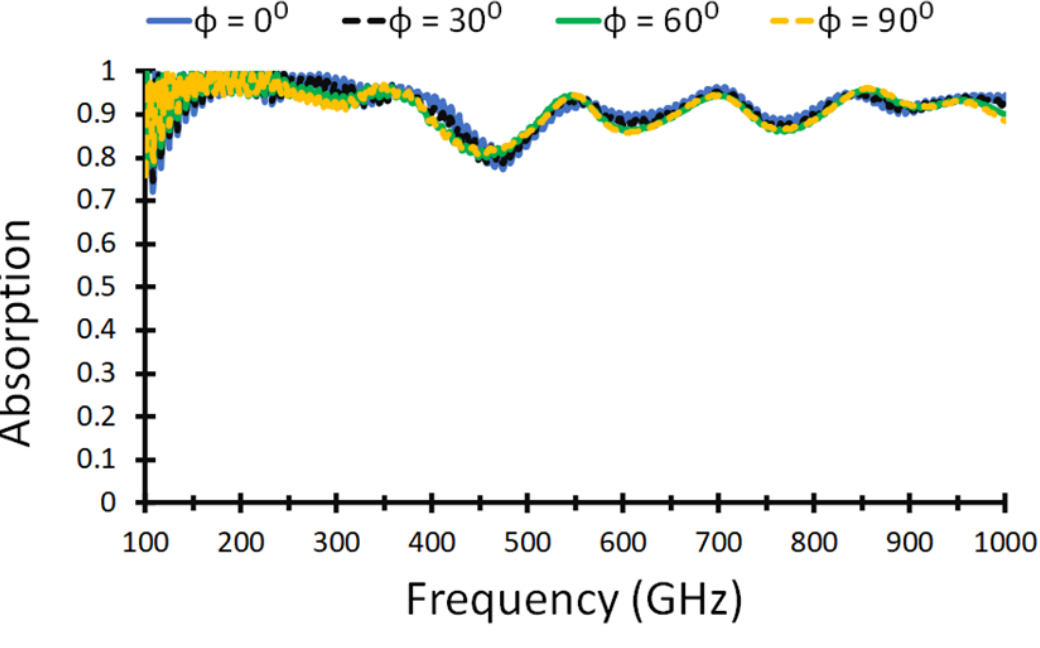
Figure 16. Absorption of the proposed optimized MMA structure for different light polarization at oblique incidence ( θ = 30°).